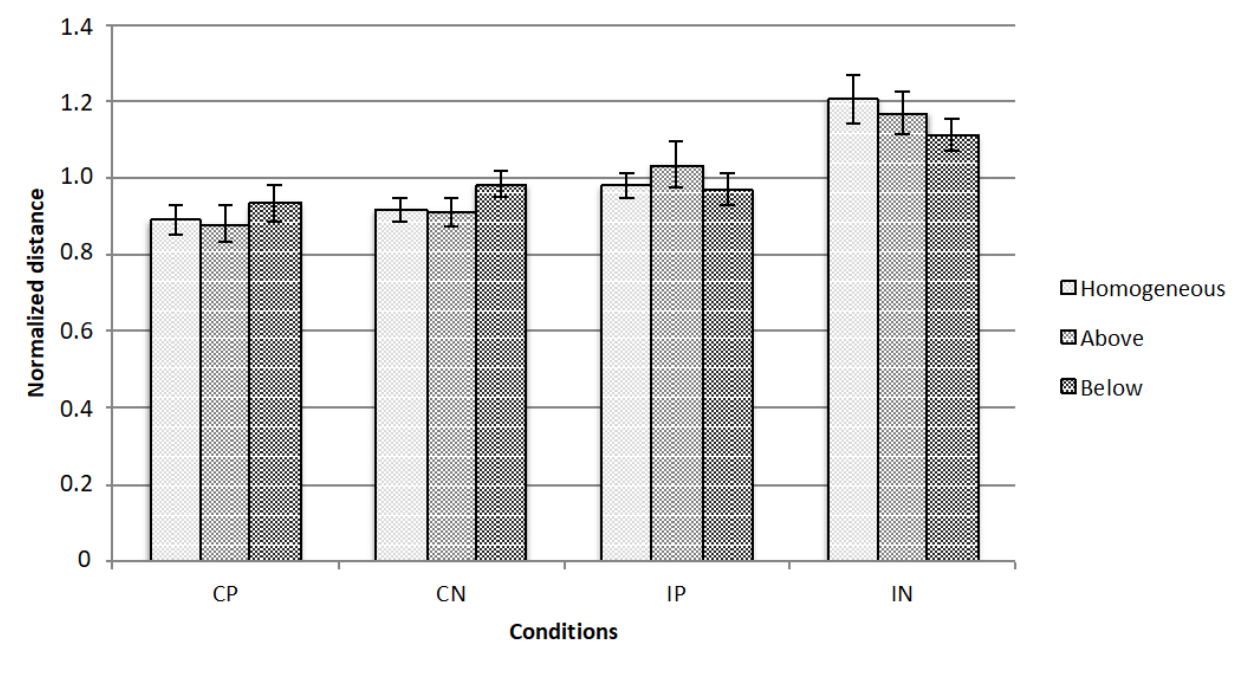
Figure 8. The figure represents the data for all the illumination conditions: The horizontal axis represents the experimental conditions (i.e., CP, CN, IP, IN), while the vertical axis is for the normalized critical distance (i.e., averaged across observers). Standard errors are